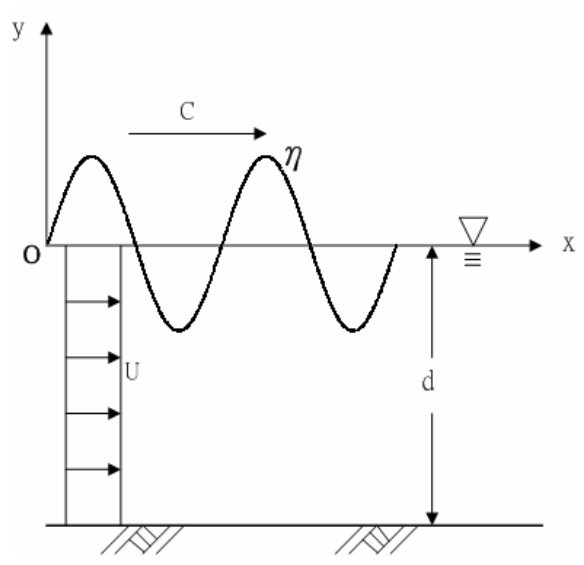
Fig. 1. Definition sketch showing a system of progressive wave train on a uniform